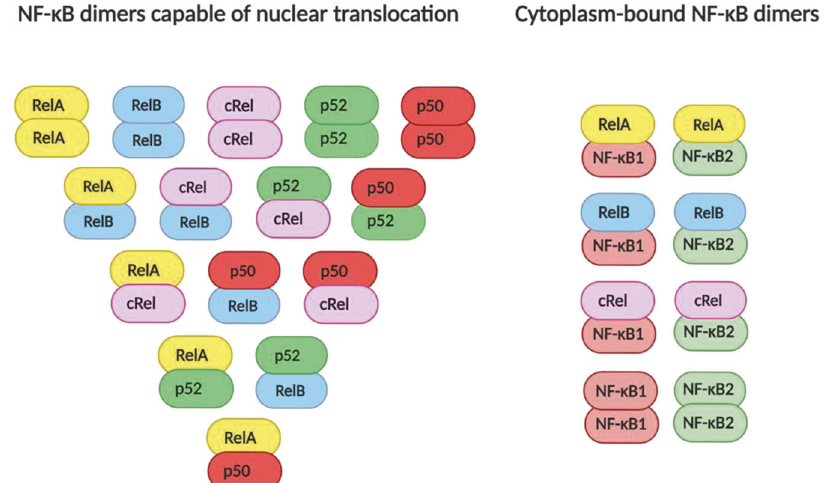
Fig. 1 NF- κ B dimers. NF- κ B dimers may be made up of any two NF- κ B subunits, however, unprocessed NF- κ B1 and NF- κ B2 retain Rel subunits in the